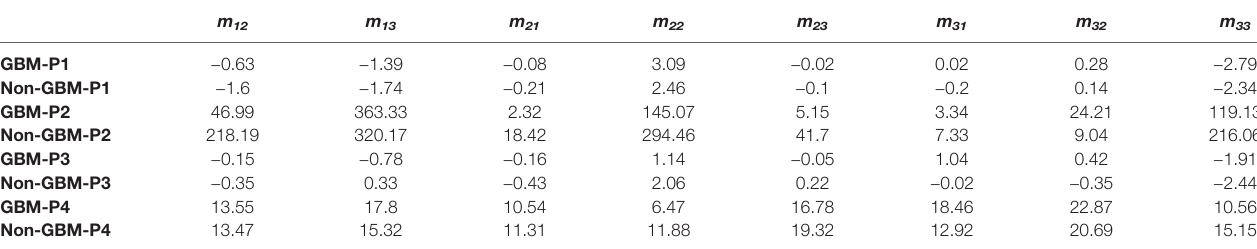
TABLE 3 | CMCs of the Mueller matrix elements for GBM (red lines) and non-GBM regions. m